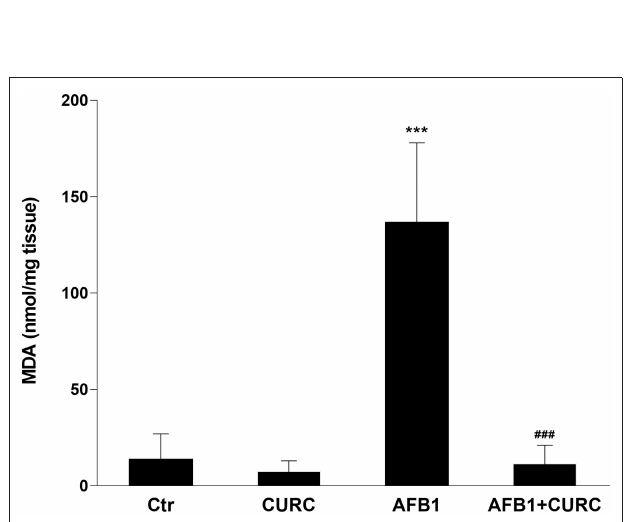
FIGURE 3 | Effects of Curcumin (CURC) and Aflatoxin B1 (AFB1) on renal lipid peroxidation, measured as MDA levels, in broilers at the end of the treatment (T10). Ctr, control group; CURC, Curcumin group; AFB1, Aflatoxin B1 group; AFB1 + CURC, Aflatoxin B1 group plus Curcumin. Data are expressed as mean ± standard deviation (SD), n = 8 (*** p < 0.001 vs. Ctr; ### p < 0.001 vs. AFB1).